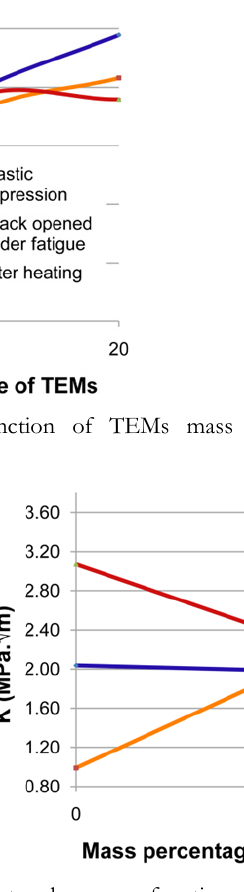
Figure 9: Fracture toughness as a function of TEMs mass fraction for adhesive AW106.